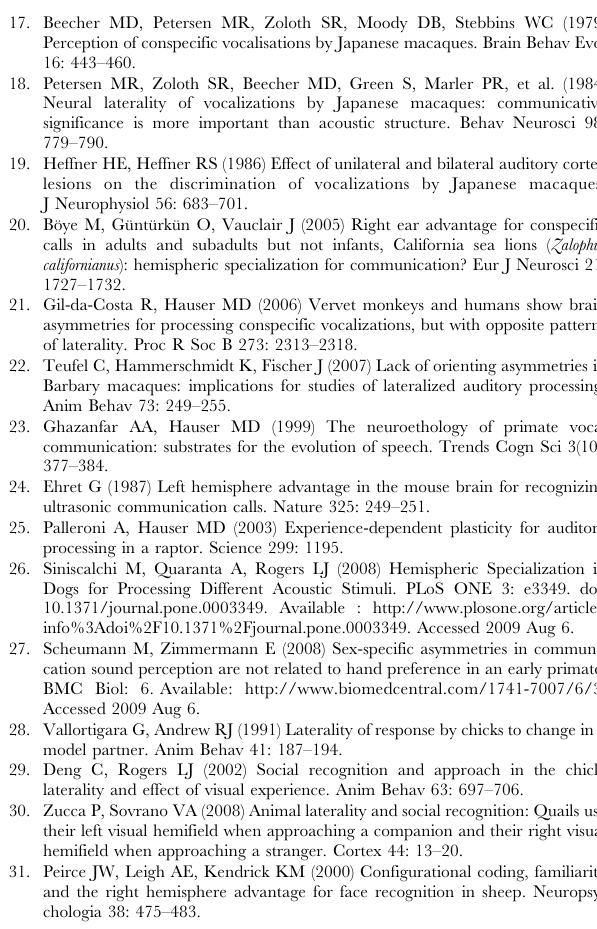
Table S1 Number of animals that turned their head right, left, or not for the different playback categories, in the first session.